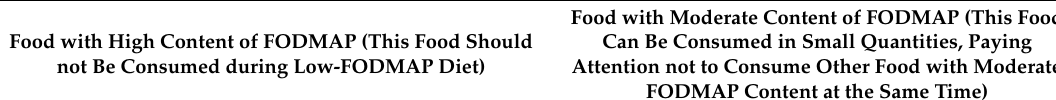
Table 1. Description of high and moderate Fodmap containing